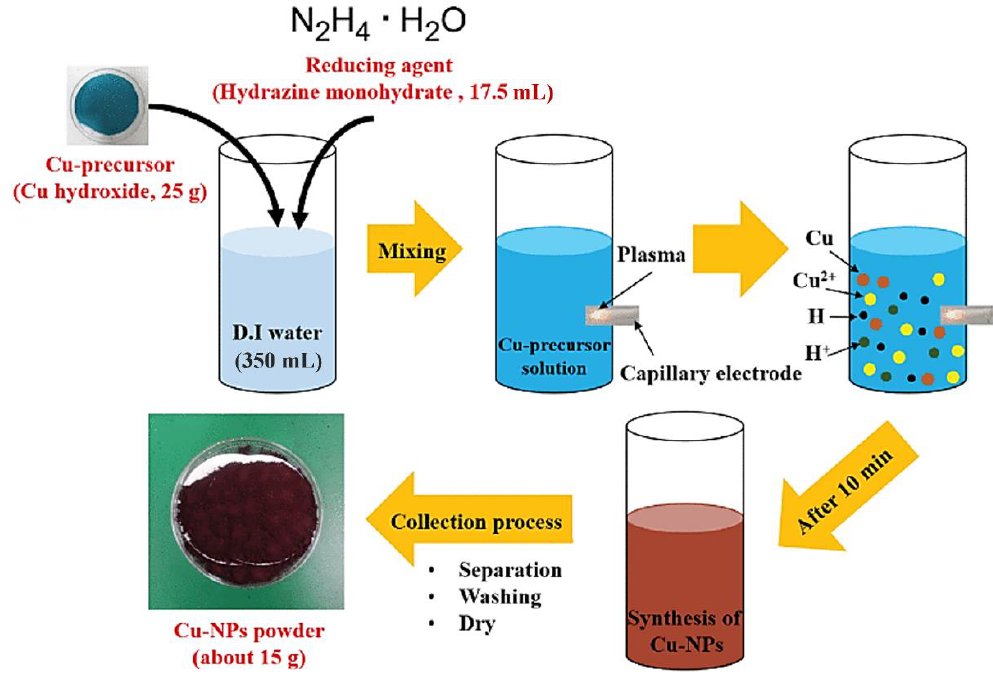
Figure 8. Schematic of the one-pot synthesis of Cu nanoparticles. Adapted from Hu et al.